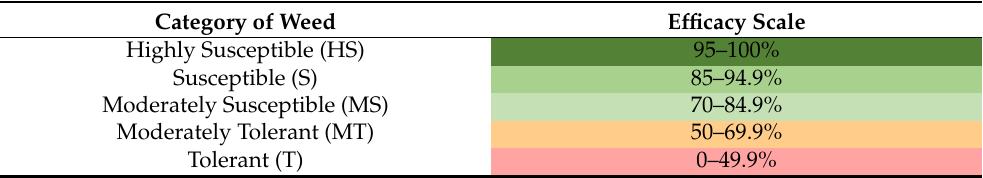
Table 6. Efficacy scale categories for weeds depending on the registered damage in field